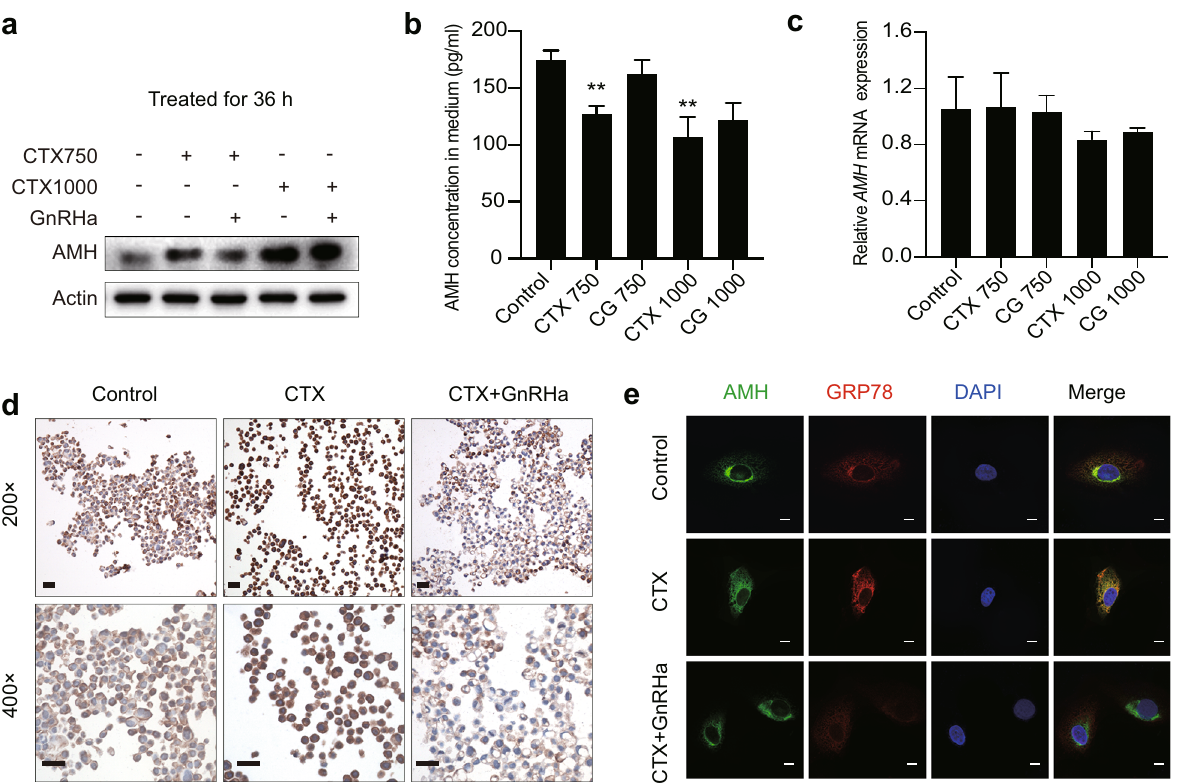
Fig. 4 GnRHa reverses the CTX-induced inhibition of AMH secretion. KGN cells were treated with CTX or CTX plus GnRHa for 36 h. a AMH concentration in KGN cells veri fi ed by western blot. Compared with CTX-treated cells, the accumulation of AMH was remitted by co-treatment with GnRHa. b AMH level in cell-culture medium veri fi ed by ELISA. Signi fi cant reductions of secreted AMH were prevented by co-treatment with GnRHa. c AMH mRNA levels of cells veri fi ed by qPCR. d Typical immunocytochemistry images demonstrate the accumulation of AMH in the cytoplasm of cells treated with 750 µg/mL CTX, which was released by co-treatment with GnRHa. e Colocalization of AMH and GRP78 in KGN cells. Cells were transfected with a plasmid expressing FLAG-tagged AMH, and were treated with the indicated reagents for 36 h. Yellow in the merged images indicates the colocalization of AMH and GRP78. Nuclei were stained with DAPI (4 ’ ,6 ’ -diamidino-2-phenylindole). CTX750, 750 µg/mL CTX. CG750, 750 µg/mL CTX + Goserelin. CTX1000, 1000 µg/mL CTX. CG1000, 1000 µg/mL CTX + Goserelin. Scale bars represent 100 µm. Error bars show the standard error of the mean. One-way ANOVA was used for b – c , * P < 0.05, ** P < 0.001, and *** P <